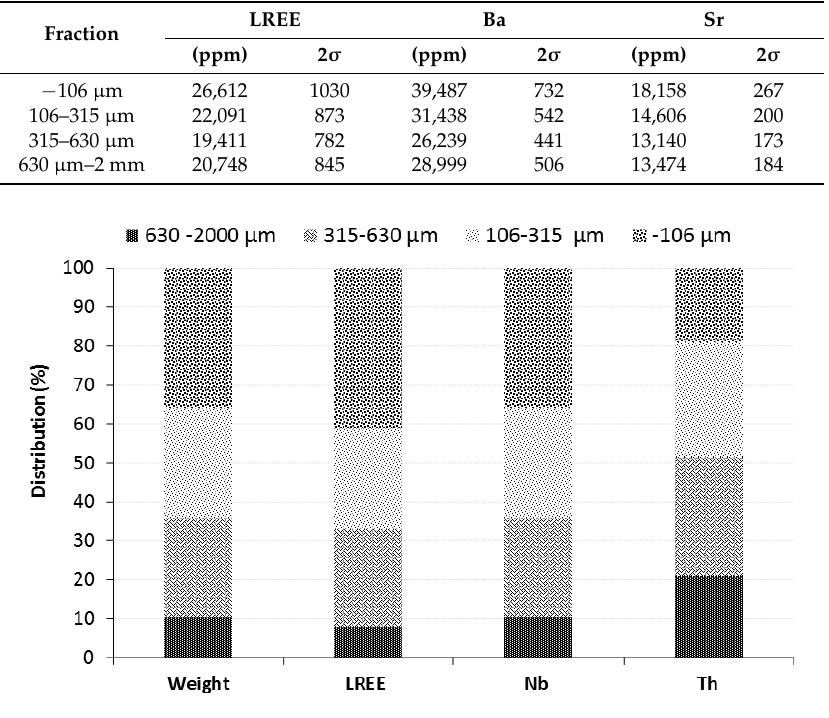
Figure 10. LREE enrichment as a function of the particle size.